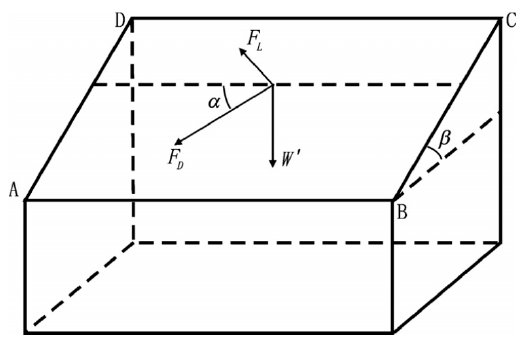
Figure 5. Slope Figure 5. Slope model.